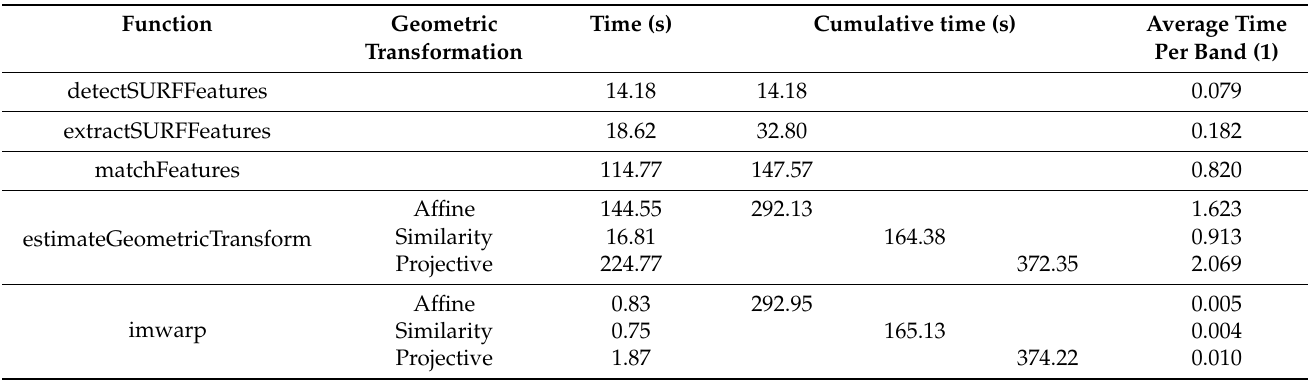
Table 7. Image registration computation time for each function in the case of 45 multispectral images acquired with the MicaSense ® RedEdge camera.